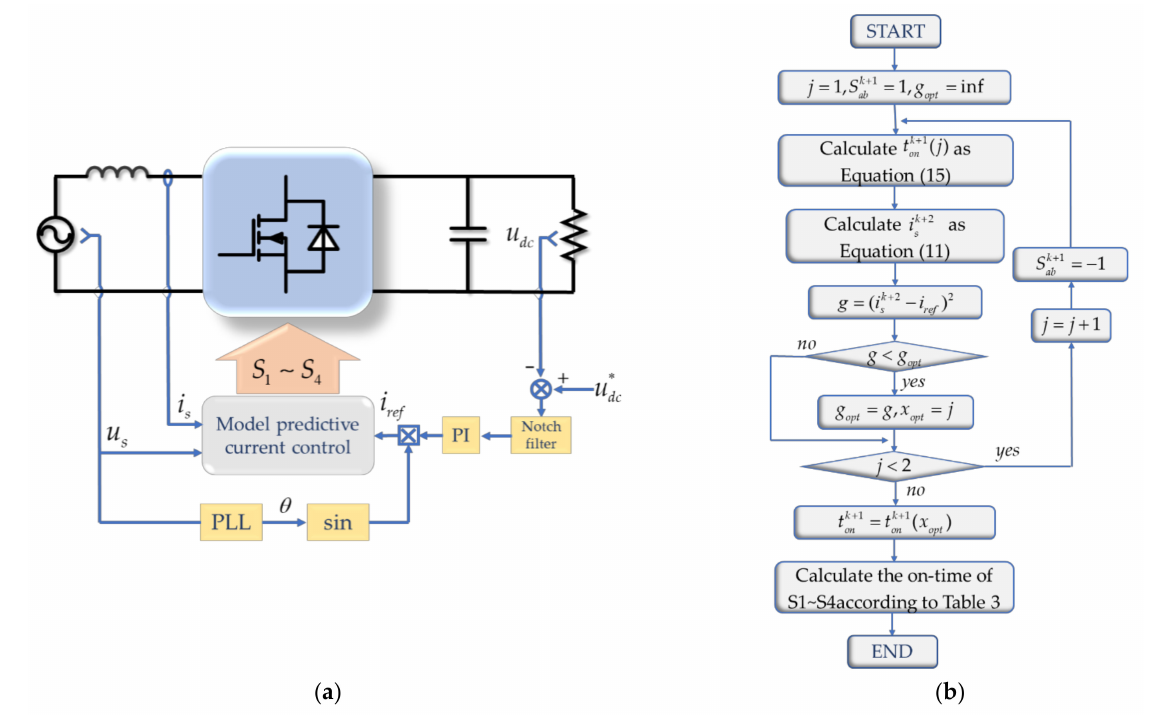
Figure 5. The control system of the proposed MPCC. ( a ) Control block diagram of the system; ( b ) Control flow chart of the inner current controller.